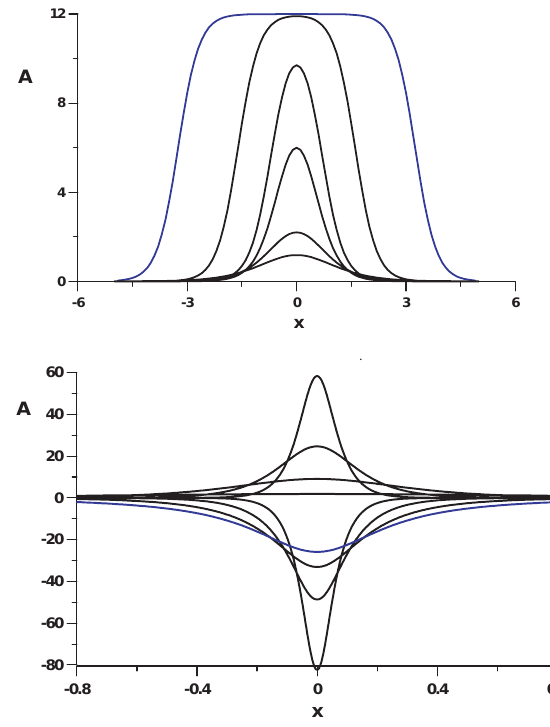
Fig. 2. Solitary wave family (17). The upper panel is for µ 1 < 0 and the lower panel is for µ 1 > 0; in both panels µ> 0, δ > 0.